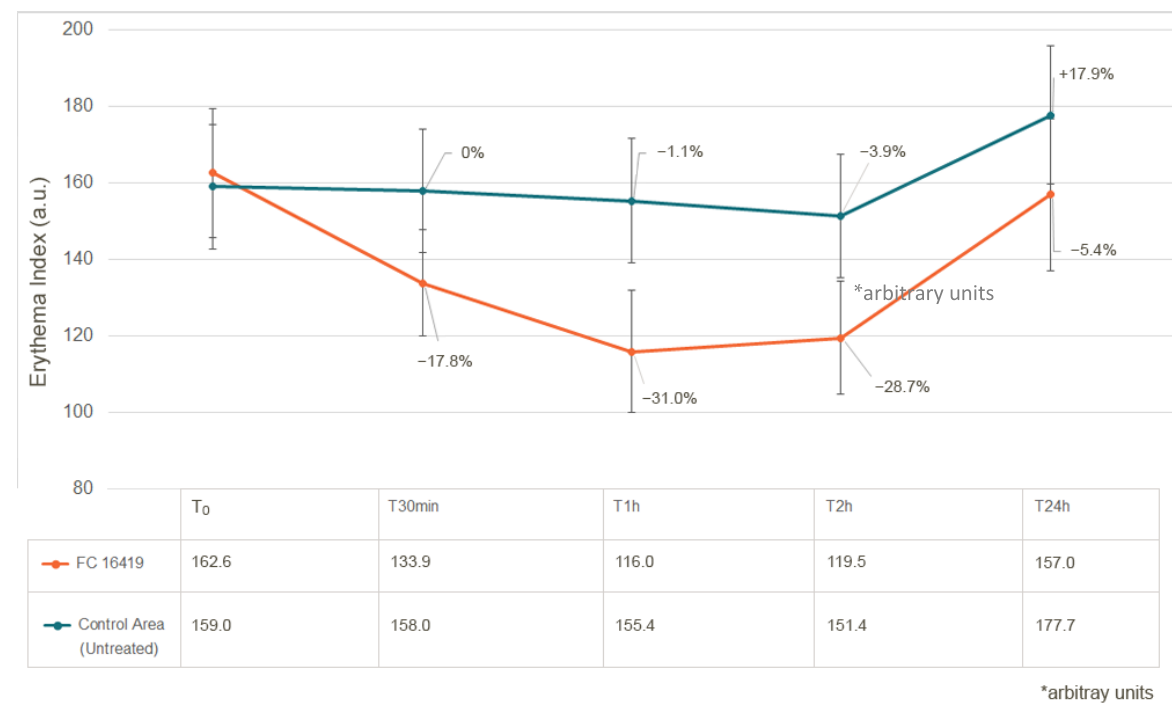
Figure 3. Mean variation of skin redness (expressed as Erythema index mean values) on data normalized versus basal values (T − 1). The graph shows the skin redness (expressed as Erythema index mean values ± SEM) caused by the UV-exposure and its % variation after application of FC 16419 or left untreated.